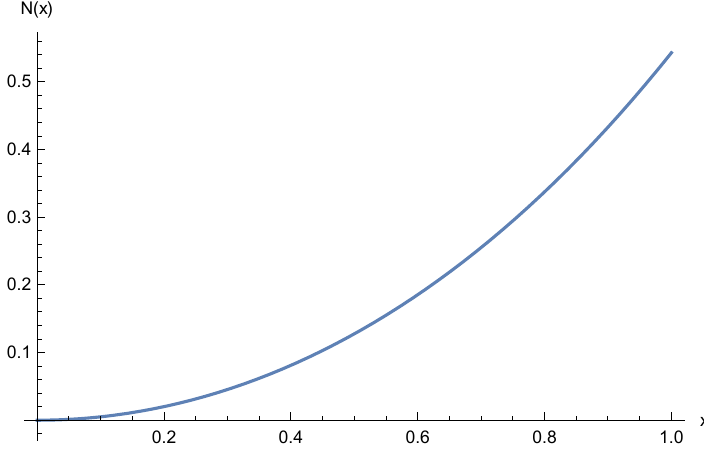
Figure 1. For the function N ( x ) , we get Figure 1, where 0 < x <